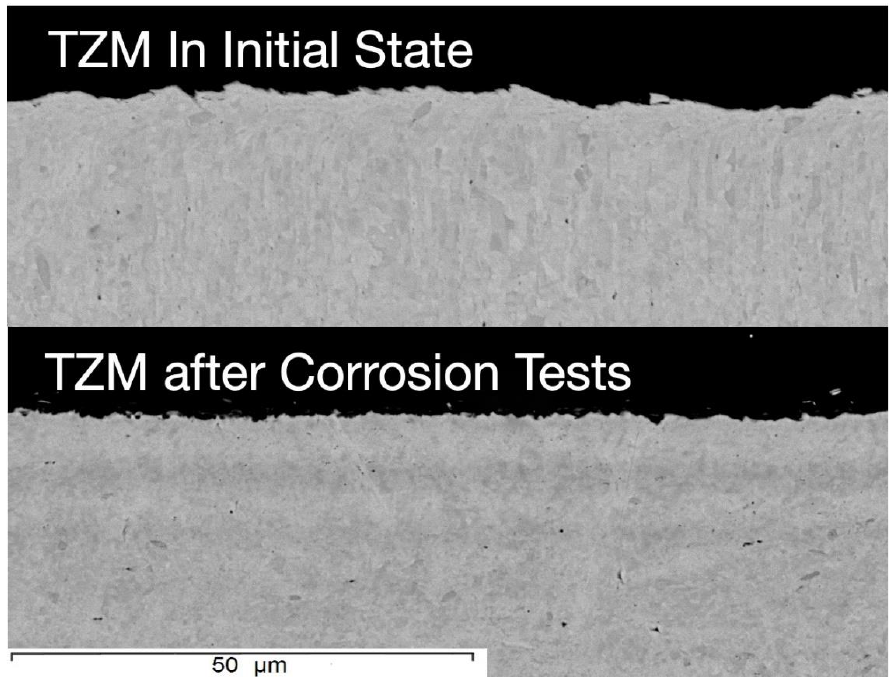
Figure 5. BSE-SEM images of microstructure of TZM alloy samples before and after contact with BLA at 650 °C for 100 h.